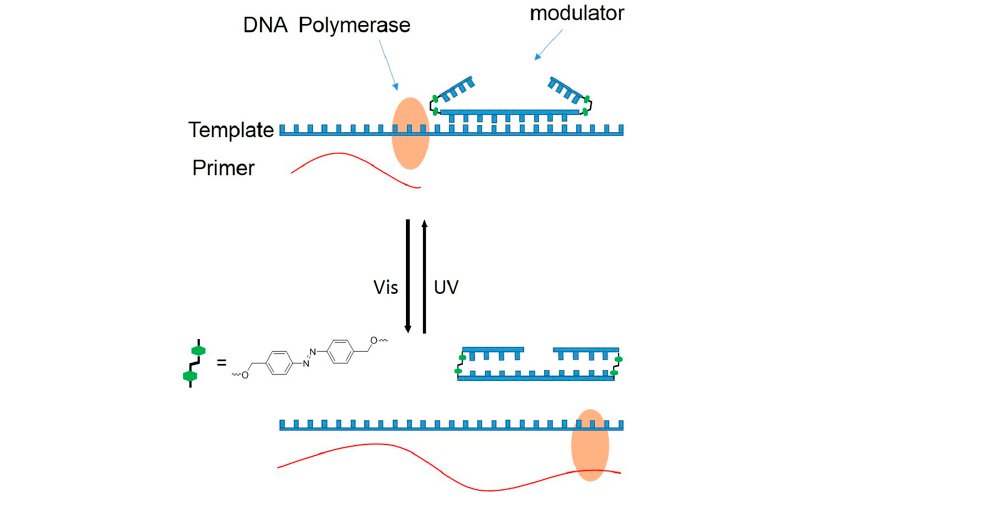
Figure 1. Strategy for photoregulating a primer extension reaction using azobenzene-linked dumbbell asODNs. UV irradiation can induce azODNs binding to the template, hindering primer extension and extending normally after visible irradiation. Table 1. Sequences of oligonucleotides and azODNs, templates and primer used in this study.